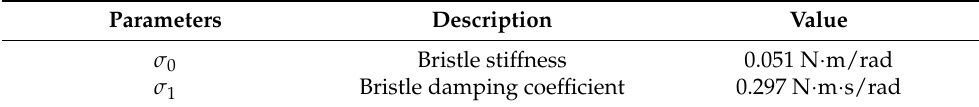
Table 4. Dynamic parameters of the LuGre model.